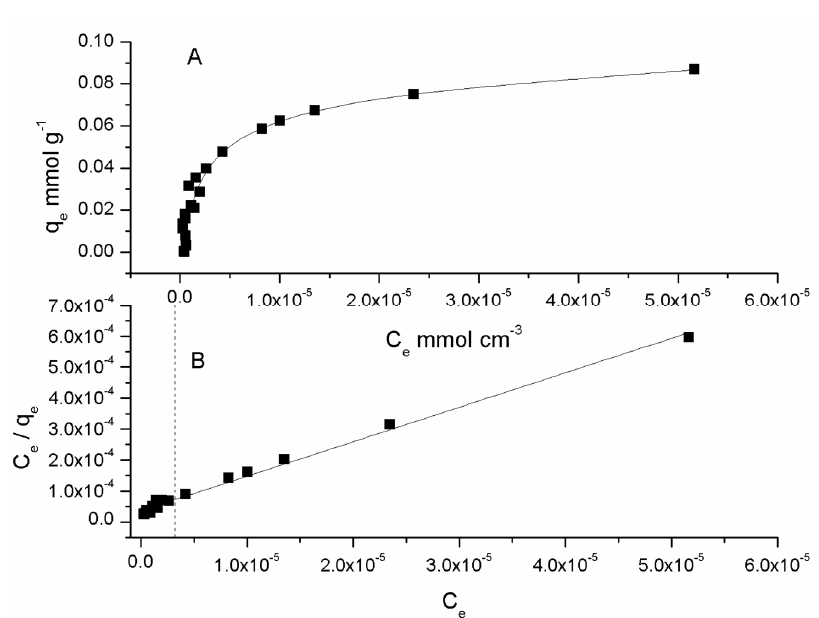
Figure 3. Cadmium (II) adsorption isotherm ( A ) and its linearized form ( B ). Aqueous phase: 6.94 × 10 − 7 –3.82 × 10 − 4 mol dm − 3 , pH = 8.0 (1 × 10 − 3 mol dm − 3 TRIS), PIM: 23.4% CTA, 54.5% NPOE, and 21.1% Kelex 100 ( w / w ).